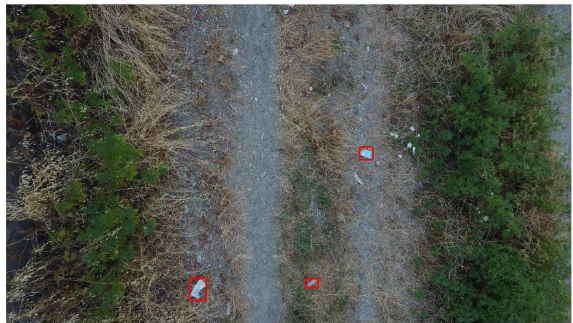
Table 4. Localization